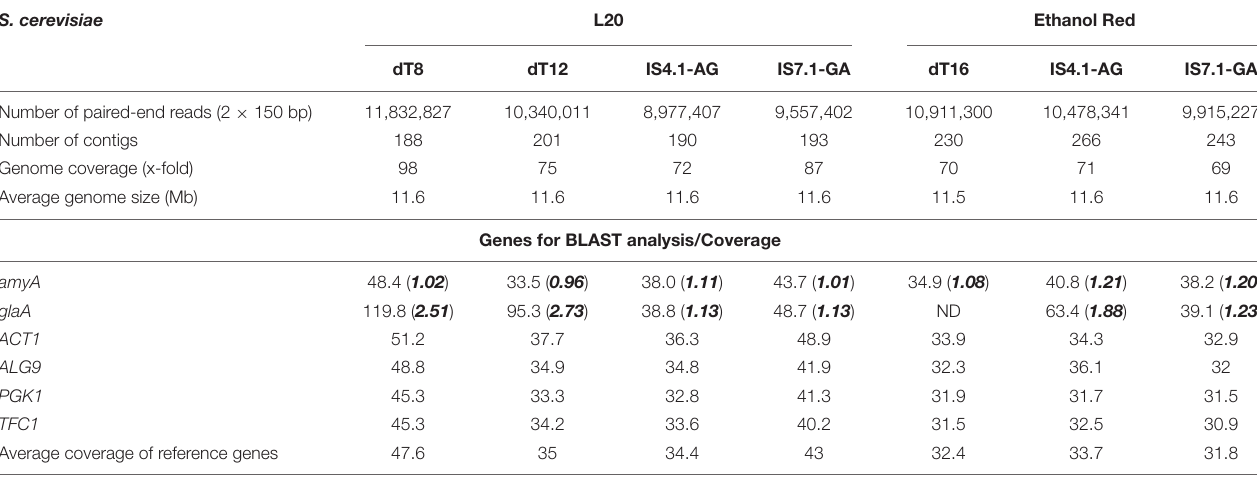
TABLE 5 | Results of Illumina sequencing of recombinant S. cerevisiae L20 and Ethanol Red strains obtained in this study. S. cerevisiae L20 Ethanol Red dT8 dT12 IS4.1-AG IS7.1-GA dT16 IS4.1-AG